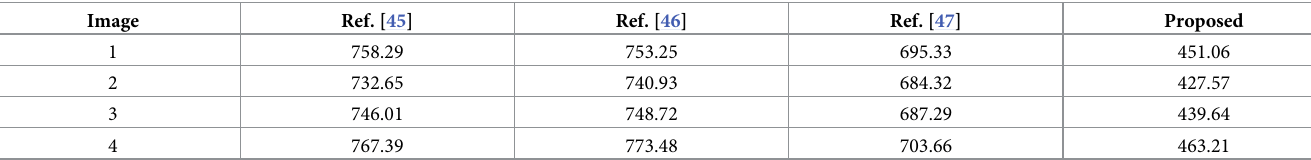
Table 15. The execution time performance (in s) evaluation of various image contrast enhancement approaches. Image